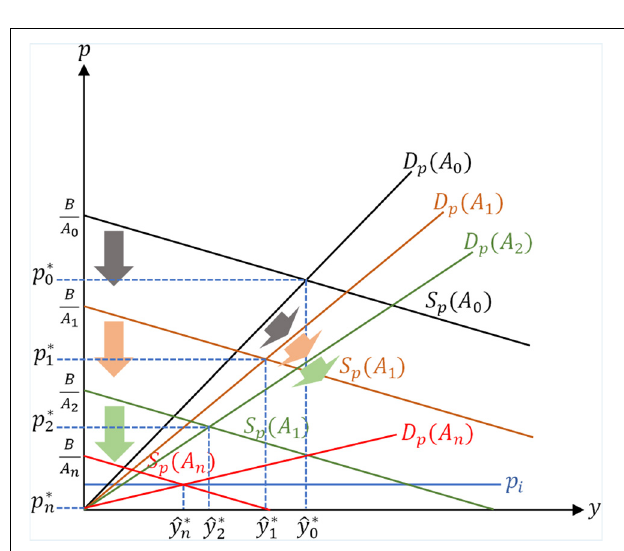
FIGURE 3 | Dynamics of equilibrium with technological